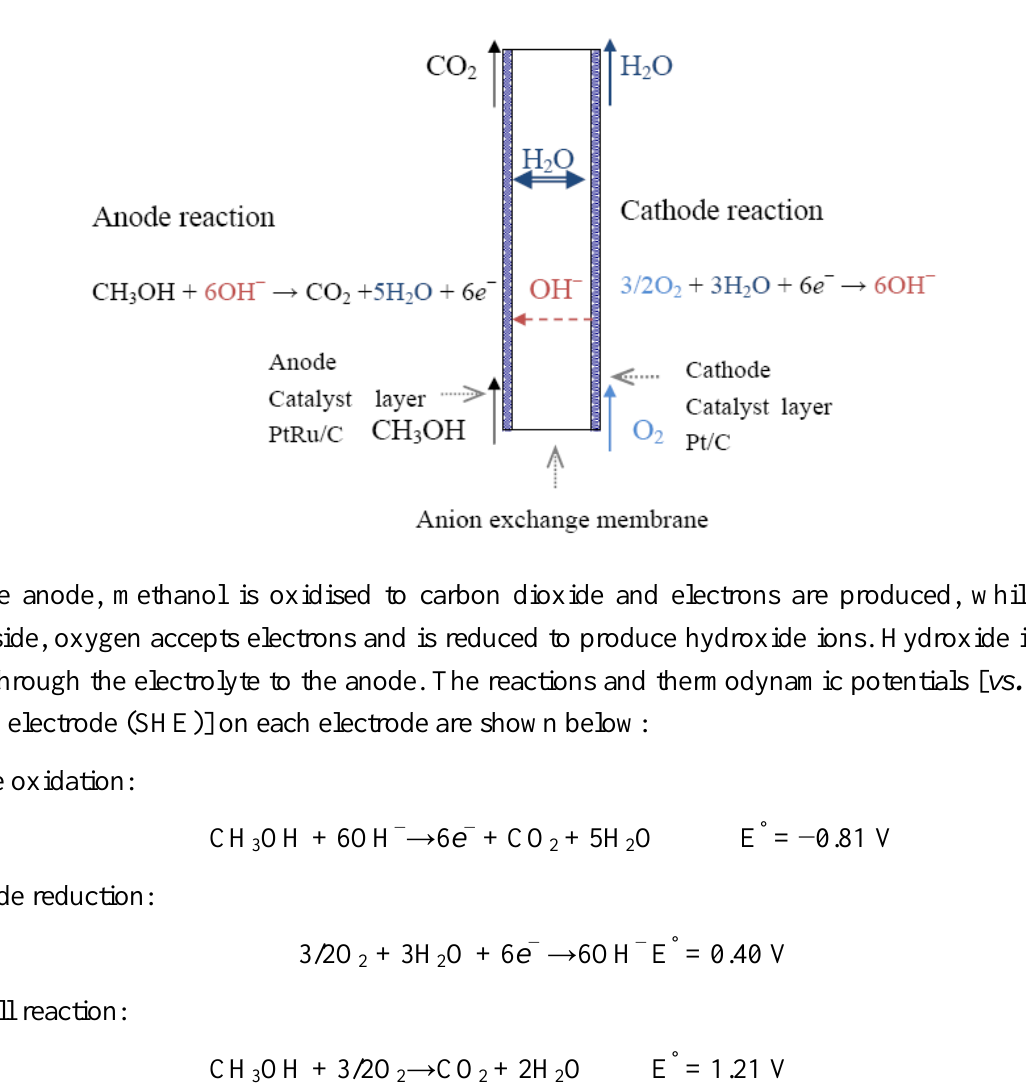
Figure 1. Schematic diagram of direct methanol alkaline fuel